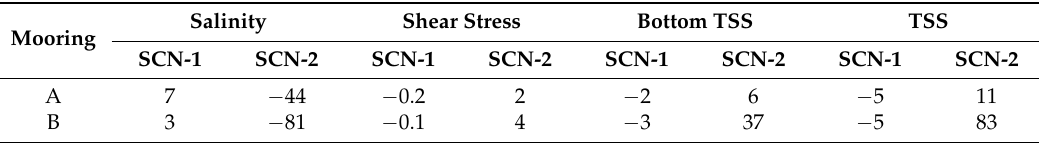
Bottom TSS corresponds to TSS concentration in the lower 3% of water column.